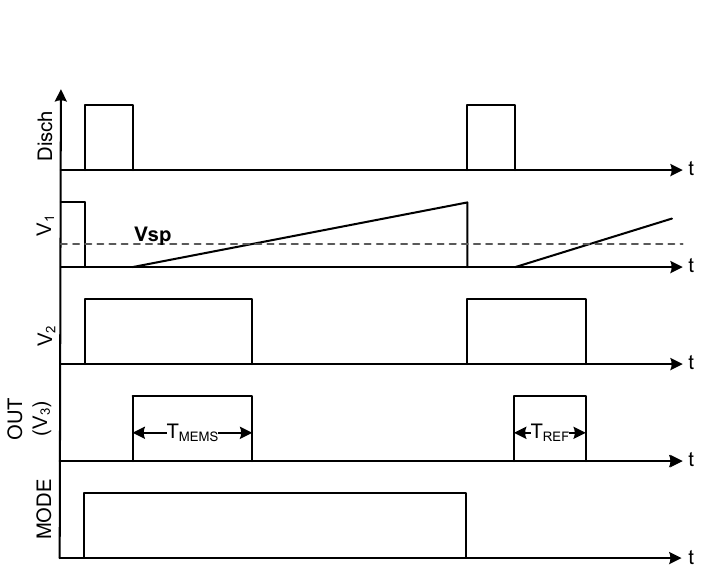
Figure 1. Proposed architecture.